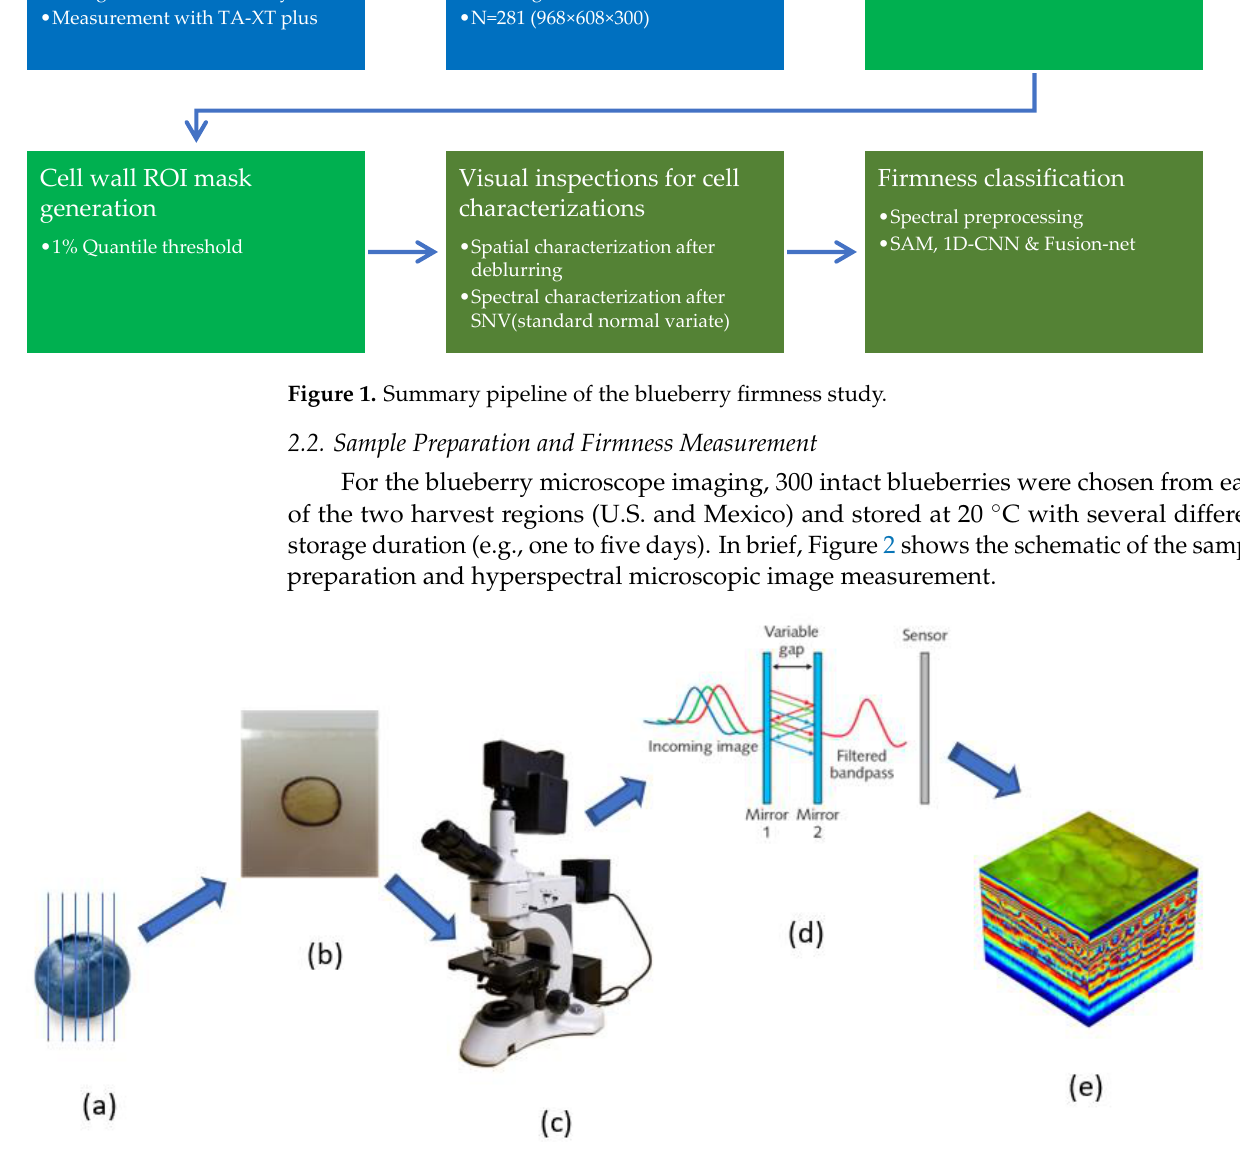
Figure 2. Schematic of sample preparation and hyperspectral microscope image measurement. ( a ) Blueberry sample with cutting direction; ( b ) blueberry on slide for scanning; ( c ) hyperspectral microscope; ( d ) Fabry–Perot Interferometer (FPI) for acquiring hyperspectral data; ( e ) hypercube from blueberry sliced sample. After the storage period specific for each blueberry, its firmness was assessed using a TA-XT plus Texture Analyzer, operated with Texture Exponent software (Version 4.0.13.0, Texture Technologies Corp., Scarsdale, NY, USA). The instrumental texture measurement with a 50 kg load cell, and a blueberry was placed between a cylindrical puncture probe of 5 mm diameter and a cylindrical stainless flat platform with the blueberry calyx end facing vertically toward the probe. The blueberry was punctured to 5 mm with 5 g auto force trigger and 1.7 mm/s test speed. The measurements on 300 blueberries produced force